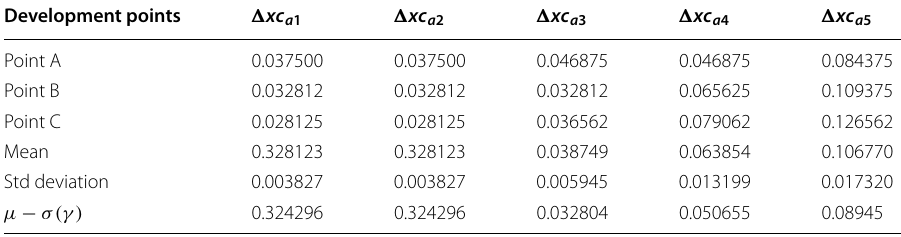
Table 2 Regions of acceptable approximation for 2nd degree Taylor polynomial Development points